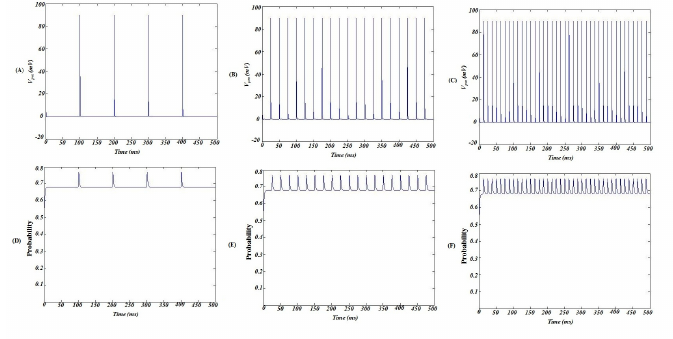
Figure 2. Top Panel: Change in transmembrane potential in presynaptic axonal terminal. Three different level of activities are used to depolarize the membrane. Panel (A) α -range of 10Hz, Panel (B) medium γ -range of 40Hz and Panel (C) high γ -range of 80Hz. Bottom Panel: Strong activity in the presynaptic terminal will intensify